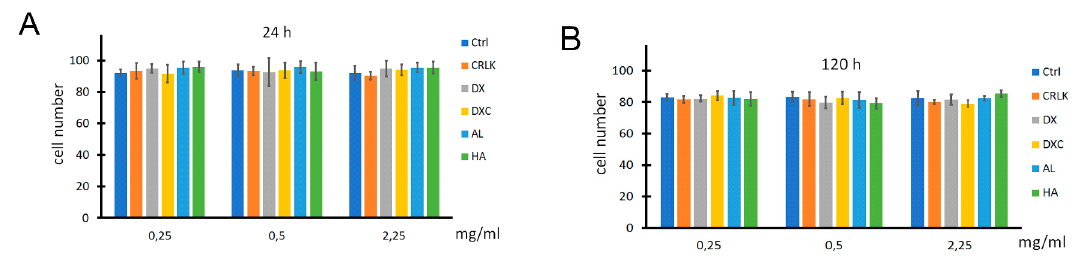
Figure 7. In vitro cytotoxicity of the NMPs vs fibroblasts 3T3. Cell viability after 24 h ( A ) and 120 h ( B ) for NMP and cross linker (CRLK) concentrations of 0.25, 0.5, and 2.25 mg / mL. The Ctrl is “control” consisting of plain cell culture.